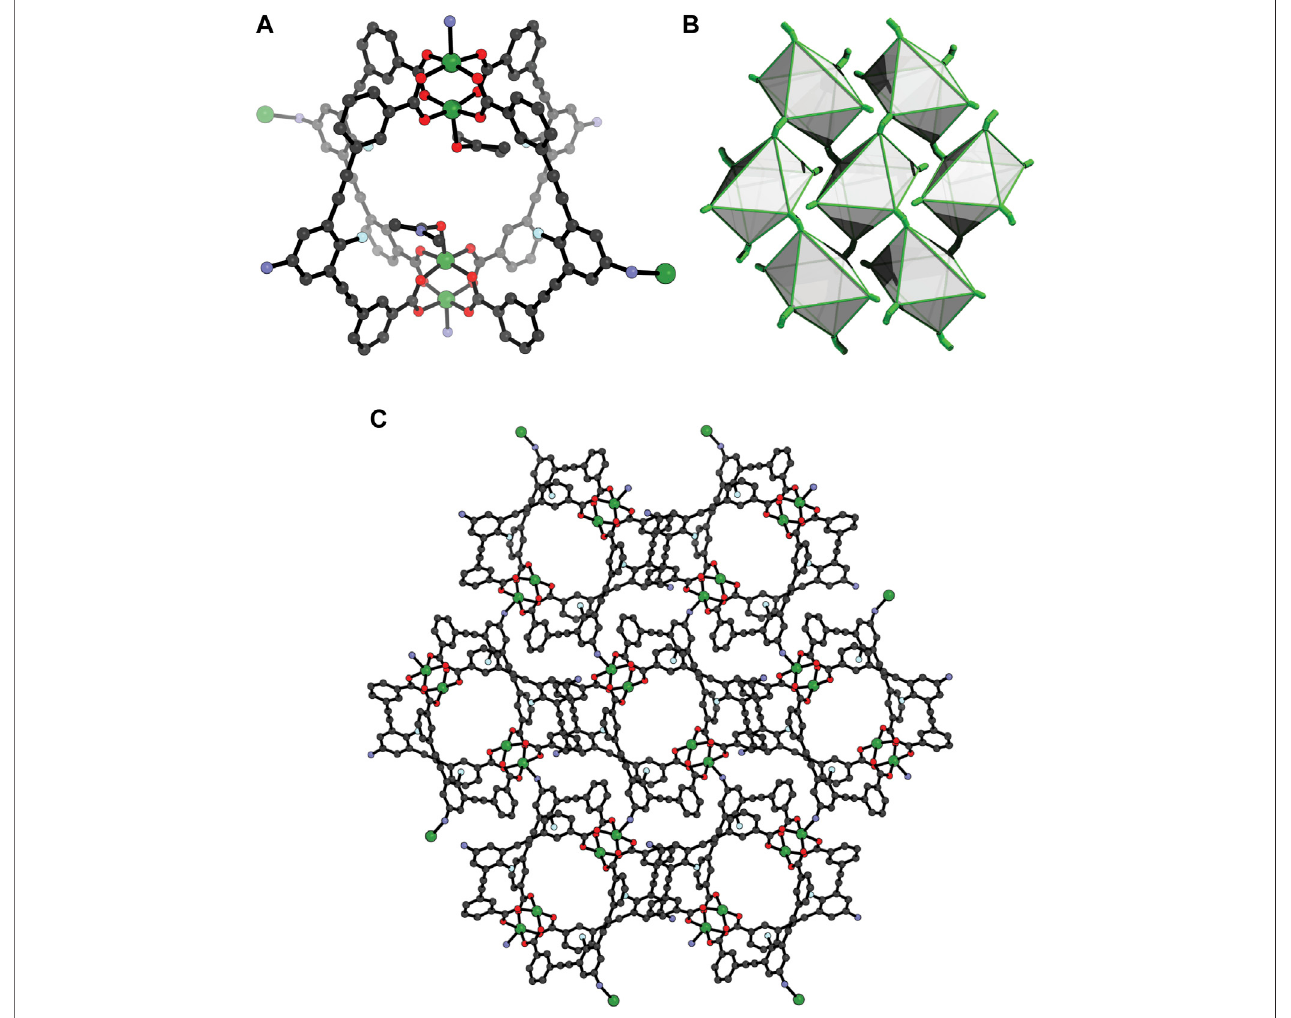
FIGURE 3 | X-ray structure of 2 (A) the Cu 4 L 2 4 unit showing the coordination to Cu(II) by two ligands in the trans direction; (B) The 4,4 net of 2 , with each cage represented as a polyhedron; (C) crystal-packing of 2 along the a axis (coordinated and pore-bound solvent removed for clarity).